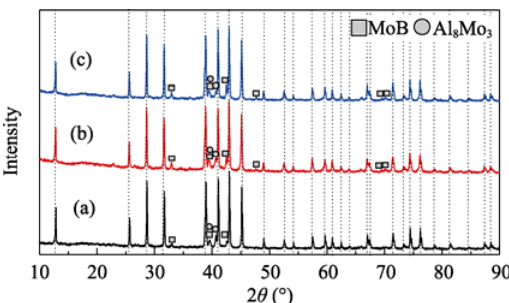
Fig. 5 XRD patterns of the samples synthesized from Mo/1.3Al/B by SHS with (a) coarse raw powders, (b) fine raw powders, and (c) ultra-fine raw powders.